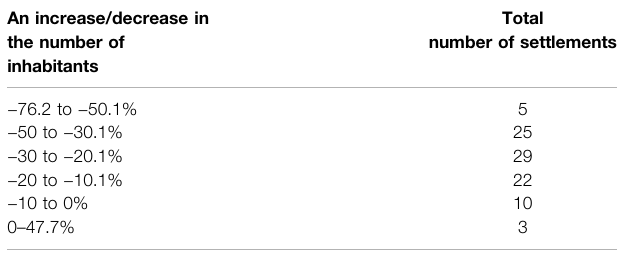
Total number of settlements